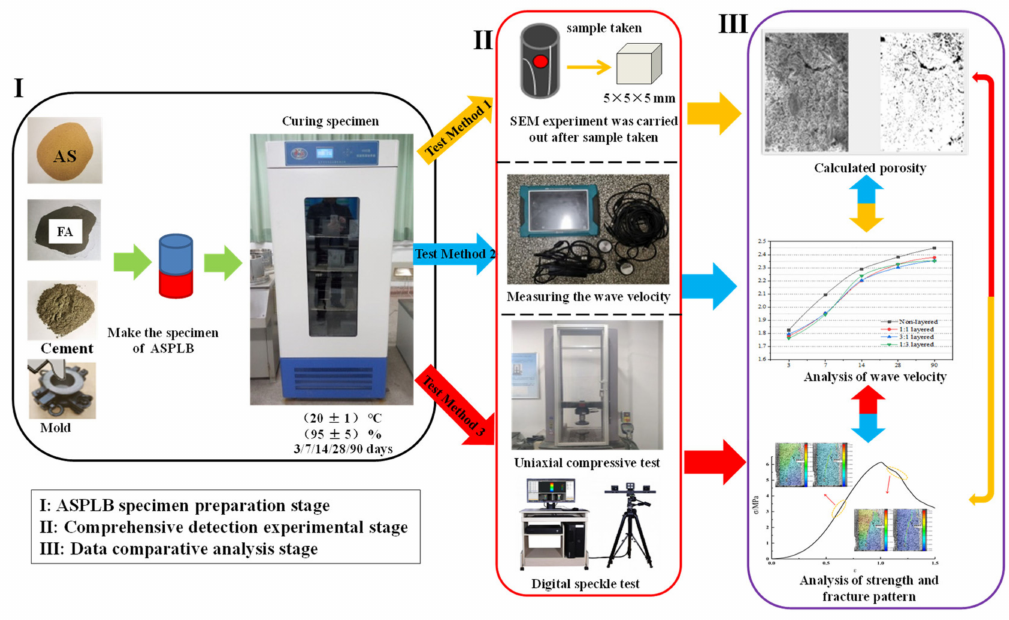
Figure 5. Flow chart of specimen preparation and the experimental